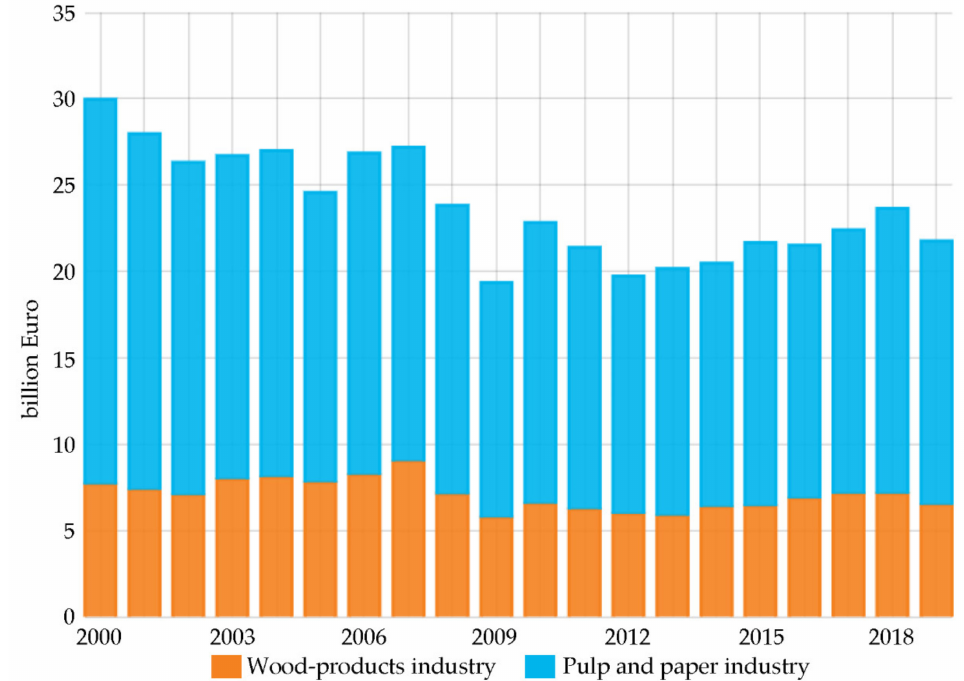
Figure 5. The gross value of Finnish forest industries